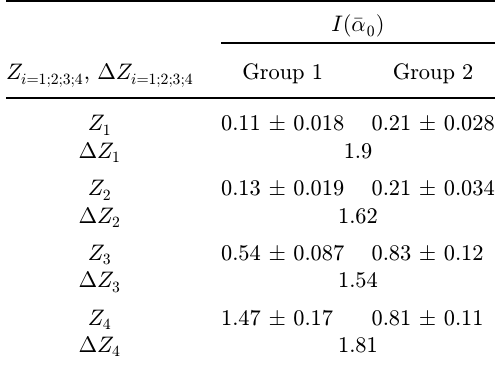
Table 3. Statistical ( Z i ) parameters of dis- ¼ 1 ; 2 ; 3 ; 4 tributions I ð (cid:3) (cid:4) 0 Þ of cytological smears of mucous coat of cervix uteri endometrium of Group 1 (dys- plasia) and Group 2 (cervical microinvasive carcinoma).